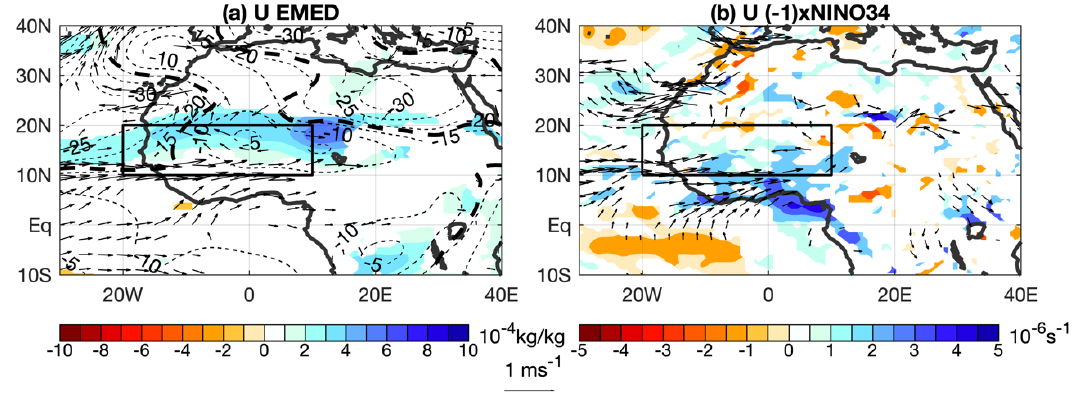
Figure 6. Dynamical fields (Aug) regression onto the time series of the expansion coefficients for SST: ( a ) Mediterranean at lag 1 (Jul) and ( b ) Nino3.4 (−1 sign to show La Niña conditions) at lag 3 (May). In ( a ), the anomalies of specific humidity at 850 hPa (colors; kg kg −1 ), horizontal wind at 850 hPa in August (arrows; m s −1 ) and Sea Level Pressure (contours; 5 Pa interval); and in ( b ), the difference between horizontal wind divergence at 200 and 850 hPa (colors; s −1 ) and horizontal wind at 850 hPa in August (arrows; m s −1 ). In both panels, only significant anomalies are represented in colors and arrows based on 95% confidence interval using a Student’s t-test. For contours in ( a ) corresponding to the Sea Level Pressure anomaly, the significant threshold corresponds to the bold contours (solid (dashed) line for positive (negative) anomalies). The black boxes delimit the Sahel region.